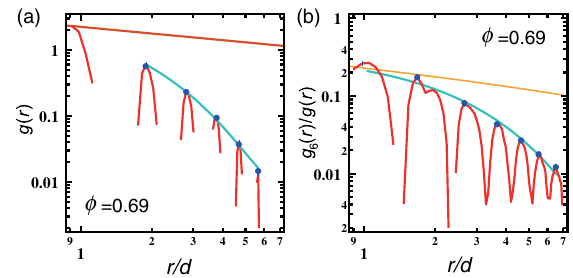
FIG. 8. Examples of the analysis of the spatial decay of g ð r Þ and g 6 ð r Þ =g ð r Þ for a rubber ball system at Γ ¼ 3 . 3 . Here, we show the analysis of (a) g ð r Þ and (b) g 6 ð r Þ =g ð r Þ at ϕ ¼ 0 . 69 , ¼ 0 . 695 . The blue points are used for which is very close to ϕ L the fittings. The blue curves are exponential fittings, whereas the red and orange lines have a slope of − 1 = 3 and − 1 = 4 , respectively. In a one-phase region, the correlation of the bond-orientational order decays exponentially and there is no indication of a power- law decay even near ϕ . The extracted correlation lengths in this L manner are plotted as a function of ϕ in Fig. 4(b). We note that in the two-phase coexistence region, this type of analysis is not